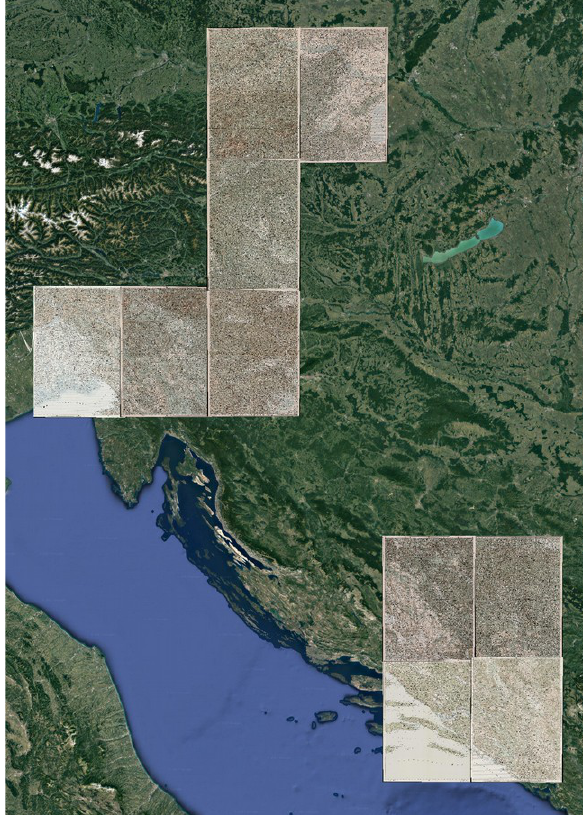
Figure 2. Overlay of the georeferenced historical maps on Google Maps satellite images (©2017